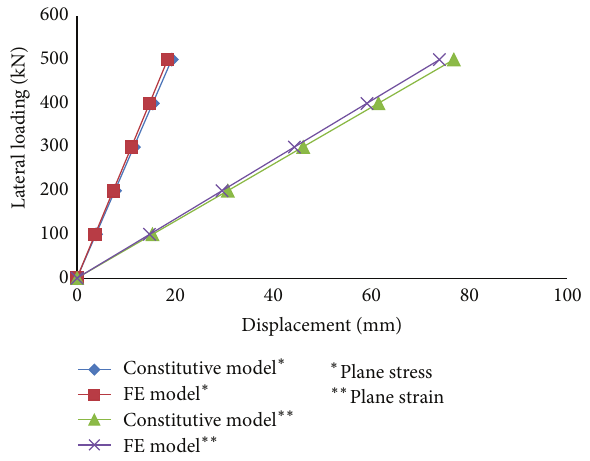
Figure7:Lateralload-deflectionoftheproposedconstitutivemodel and FE model for RC1SS.